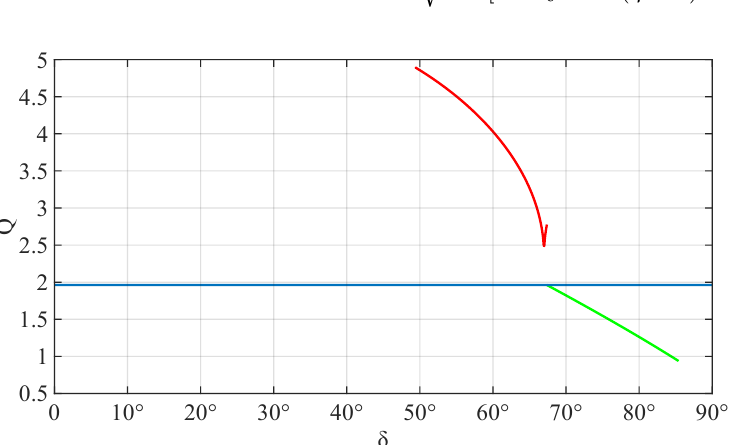
Figure 14. Drive force under transformable state C 1 and C 2 Q (5 mm) (Blue: wheel state; Red: C 1 ; Green: C 2 ).